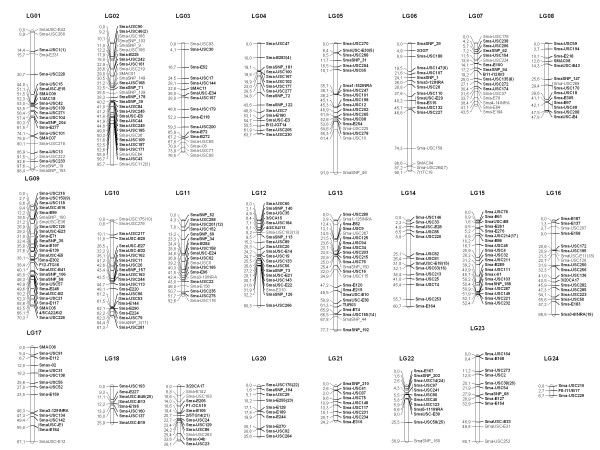
Consensus turbot map. Framework markers in bold characters; accessory markers indicated by parentheses beside the closest marker and listed at the end of Additional file 5: Figure S2; LOD < 3 markers in normal type.